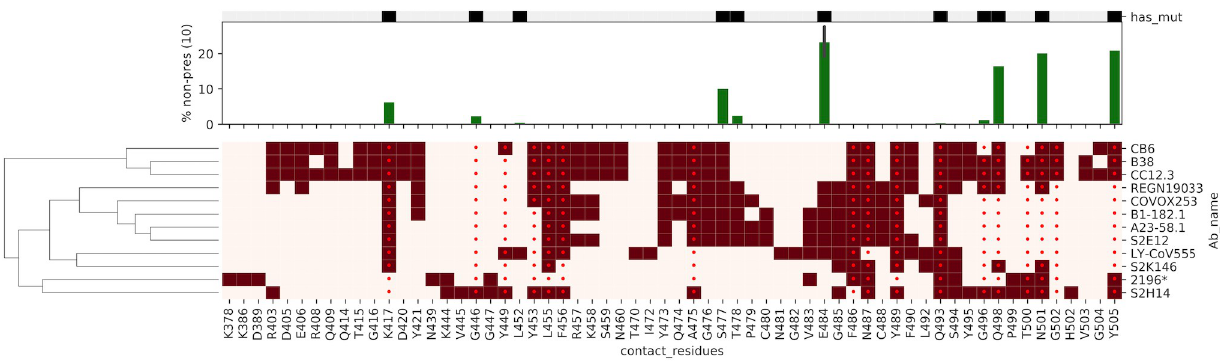
Fig 9. Overview of key amino acid residues in the RBM in or around the 486 Phe-Asn-Cys-Tyr 489 “FNCY” patch. The heatmap shows neutralizing antibodies clustered by contact residues (dark red squares), and their relation to ACE2 binding residues (red dots). The middle barplot shows the percentage of all MHC-II alleles that can now not effectively present a mutated residue compared to wildtype with a threshold of a NetMHCIIpan rank of 10. The top plot indicates which residues are mutated in the parental/WA1, Beta, Delta, and Omicron Variants of Concern. For discussion on antibodies A23-58.1 [40], B1.182.1 [40], SE12 [21, 41], and S2K146 [42] see text.